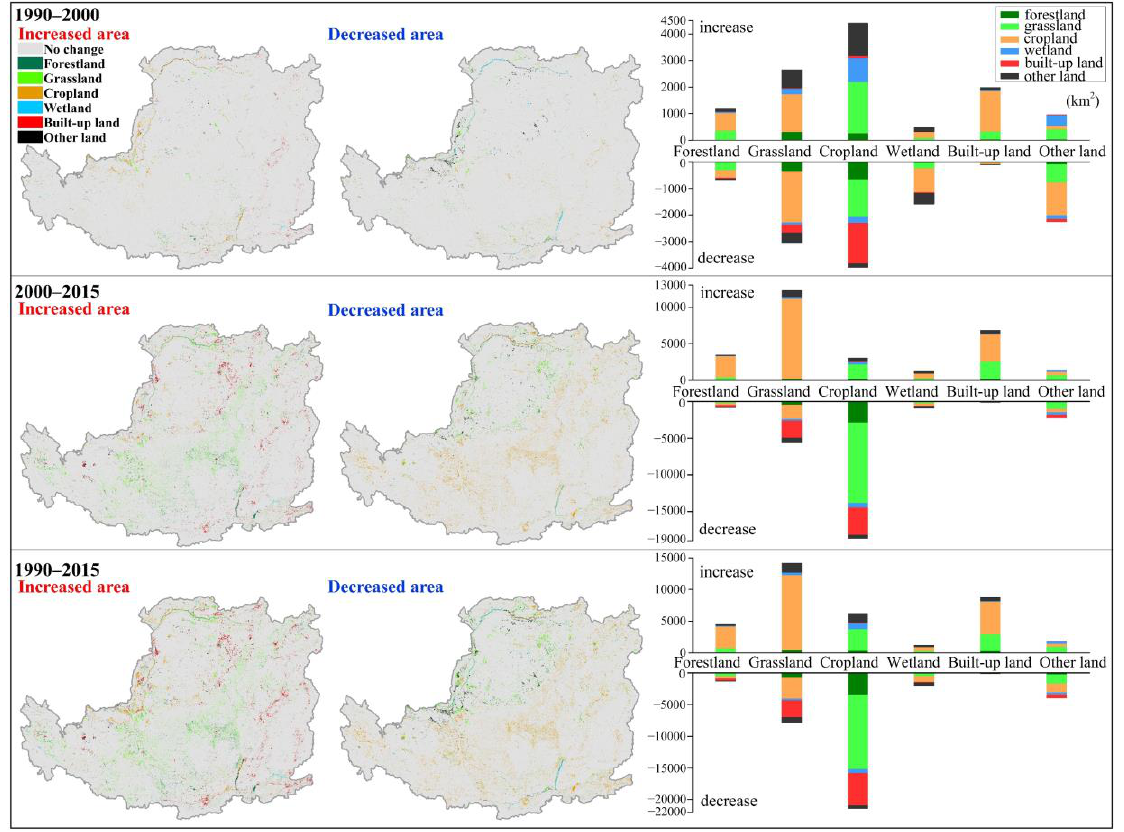
Figure 4. Spatial pattern (left panel) and magnitude (right panel) of increased and decreased land-use types.